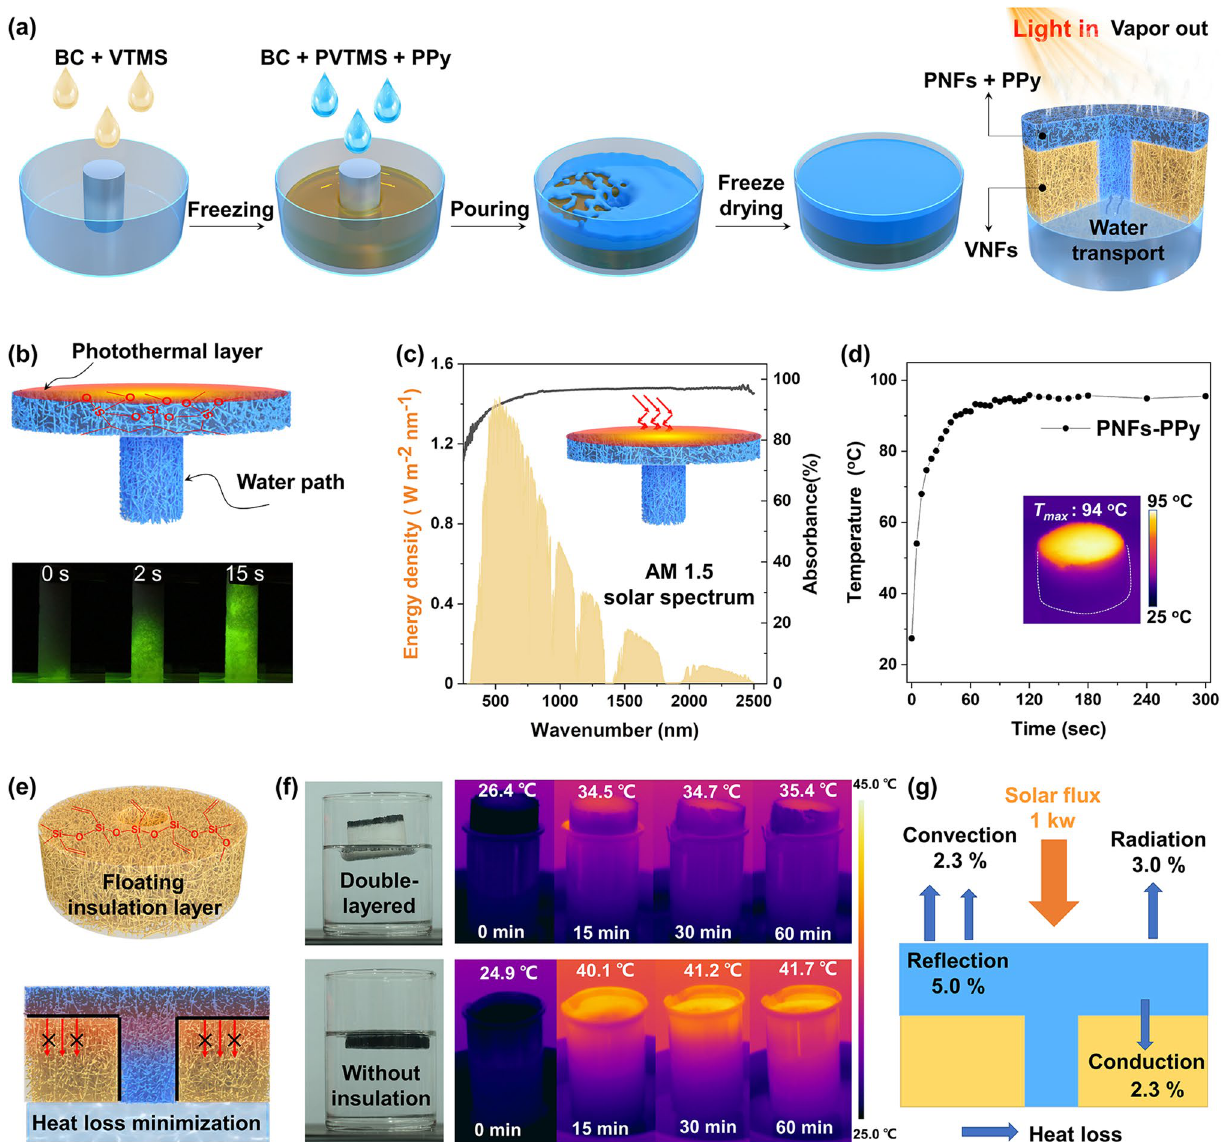
Fig. 4 Superwettable aerogels for solar-driven interfacial evaporation. a A process flow scheme of evaporator device integration. b (Top) Sche- matic of the umbrella-shaped PNFs-PPy and (bottom) water diffusion of pure PNFs. c Absorption spectra of PPy-doped PNFs aerogel and solar irradiance weighted by standard AM 1.5G solar spectrum. d Temperature rise recorded from the top surface of PNFs-PPy upon 1 sun irradiation (1 kW m −2 ). e Schematic of a porous VNFs insulator that suppresses the downward heat loss. f Infrared images of double-layered evaporator and single-layered PNFs-PPy illuminated under 1 sun for 60 min. g A heat loss diagram of our